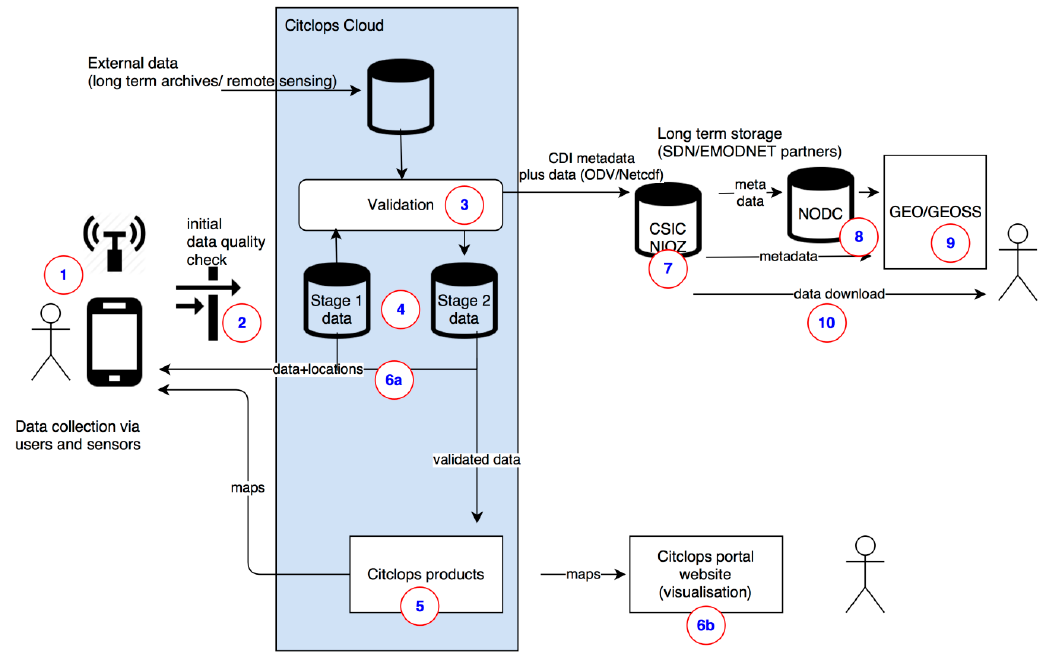
Figure 3. Data flow to users and external systems for affordable tools developed in Citclops. Data are collected by users with affordable sensors, and are centrally stored in a database for metadata and files. Data are visualized for users in the Citclops/EyeOnWater portal, and then sent to data portals like EMODnet and GEOSS from the Citclops portal or national data centres. Remote sensing data can be integrated as an additional step for validation and/or visualization of the added data.